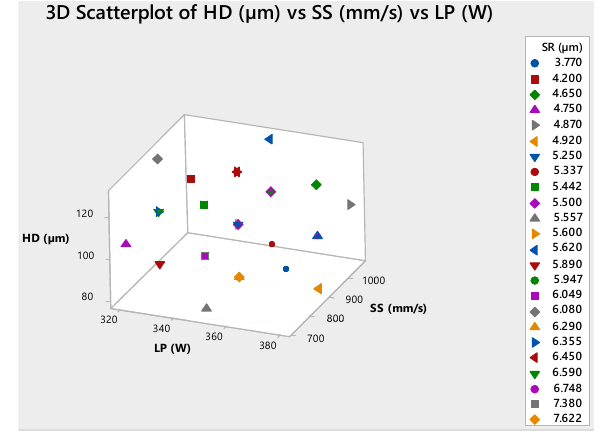
Figure 5. SR in respect to each of the parameters.